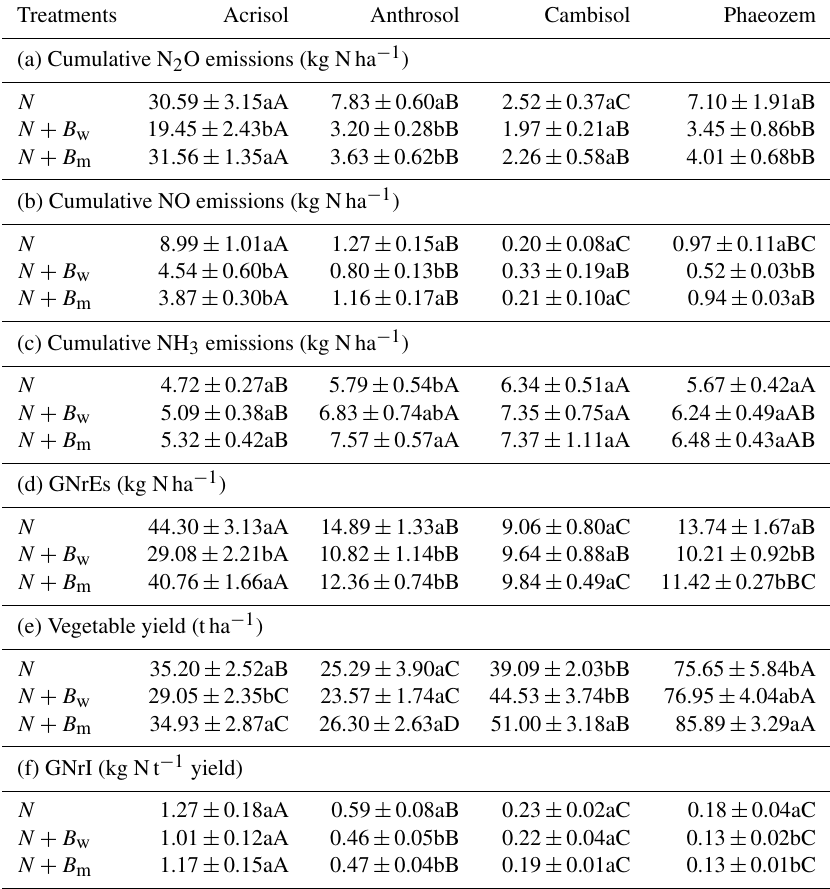
Table 3. Cumulative gaseous nitrogen (N 2 O, NO and NH 3 ) emissions, gaseous reactive nitrogen emissions (GNrEs), vegetable yield and gaseous reactive nitrogen intensity (GNrI) under the different treatments across the four soils.